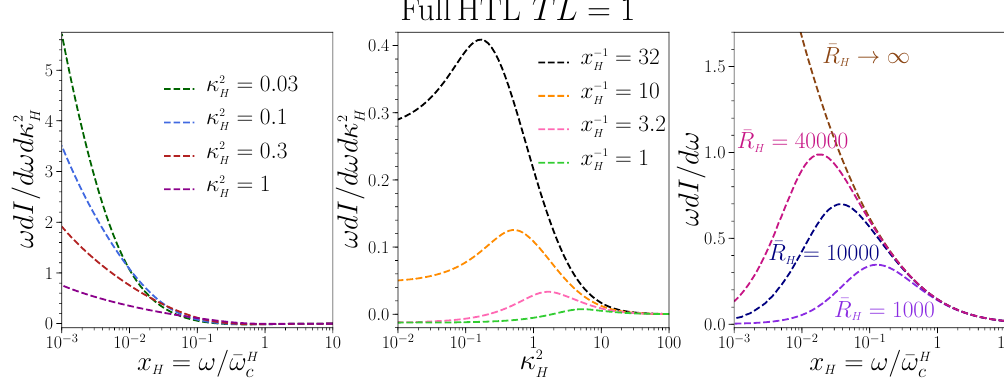
Figure 7 . Left: full medium-induced k ? -di(cid:11)erential gluon radiation spectrum for the HTL collision rate for a medium with TL = 1 as a function of rescaled gluon energy x H = != (cid:22) ! H of the rescaled gluon transverse momentum (cid:20) H = k=m D . Center: same as left panel versus (cid:20) 2 (cid:12)xed values of x H . Right: energy distribution for the HTL collision rate for a medium with TL = 1 for di(cid:11)erent values of (cid:22) R H = m 2 L 2 = 2 as a function of x H D